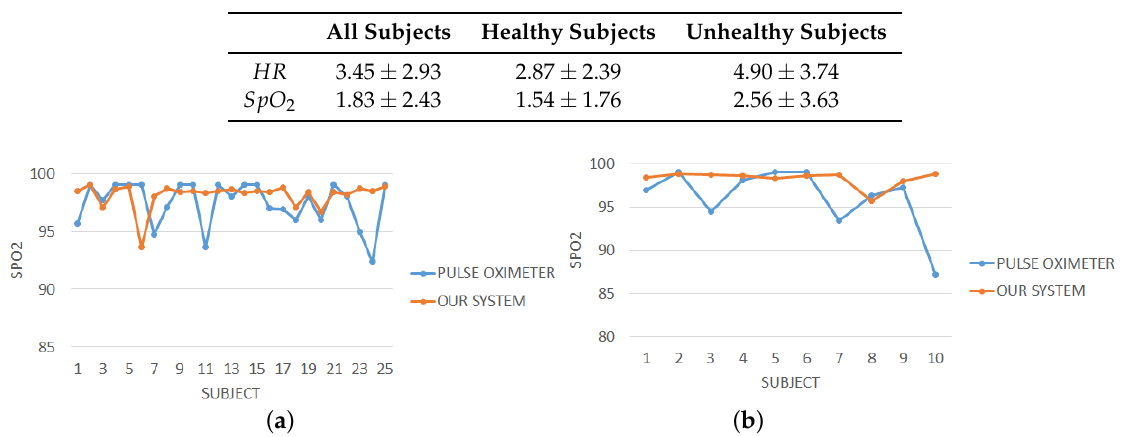
Figure 10. Comparison between HR measurements computed by our contact-less system and the pulse oximeter for the 25 healthy subjects ( a ) and for the 10 subjects suffering from cardiovascular disease ( b ). Table 3. Mean absolute error and standard deviation obtained by comparing our contact-less system and the pulse oximeter.